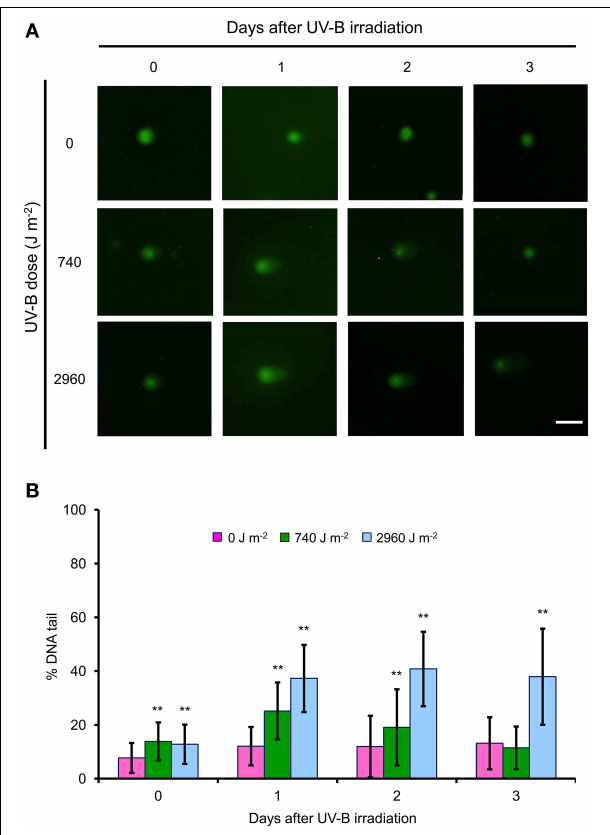
FIGURE 5 | Single-strand breaks induced by low- and high-dose UV-B irradiation. Frequencies of DNA strand breaks were measured by the comet assay ( Menke et al., 2001). BY-2 cells were irradiated with UV-B (0, 740, or 2960 J m − 2 ) and cultured for 3 days. Nuclei were assayed by using the alkaline/neutral protocol, which detects mainly single-strand breaks ( Menke et al., 2001 ). (A) SYBR Green–stained nuclei at 1, 2, and 3 days after 0, 740, and 2960 J m − 2 of UV-B irradiation. Bar = 100 µ m. (B) DNA strand breaks were quantified by using the KBI plug-in “Cometassay” for ImageJ software and expressed as percentage of DNA in the tail. Error bars show SD. Asterisks indicate significant differences from control (no UV-B) ( P < 0 . 01 ). Typical results from two independent experiments are